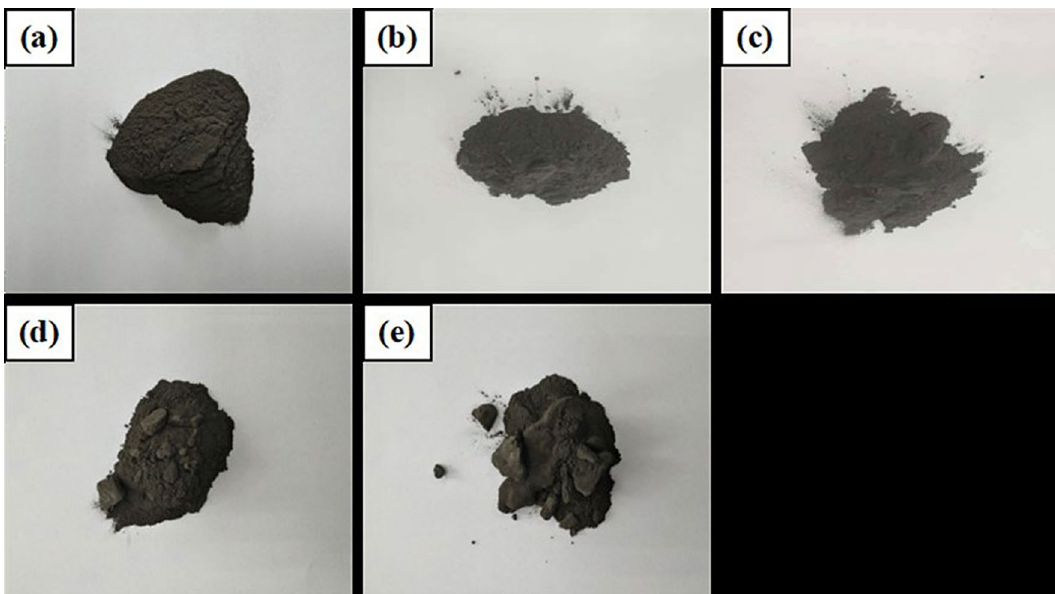
Figure 2. Morphology of reduced niobium powder with various amounts of magnesium additions. ( a ) Original niobium powder, ( b ) 200% theoretical amount, ( c ) 300% theoretical amount, ( d ) 400% theoretical amount, and ( e ) 500% theoretical